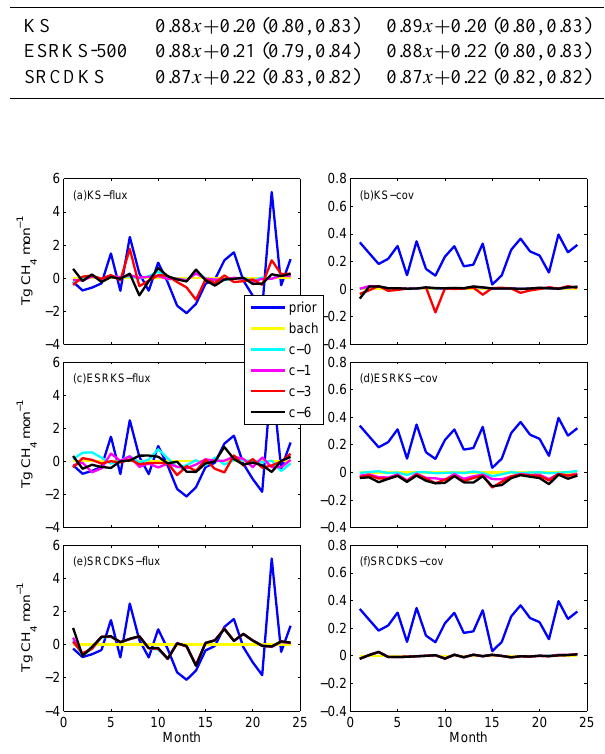
Fig. 3. Two-year comparison of the posterior fluxes and posterior uncertainties between inversions using the different Kalman update smoothers and those from the linear batch inversion. Results from the linear batch inversion have been subtracted from the time series for a better illustration. The ensemble size for ESRKS is 500, and that for SRCDKS is 101. None of the Kalman type smoothers uses interval